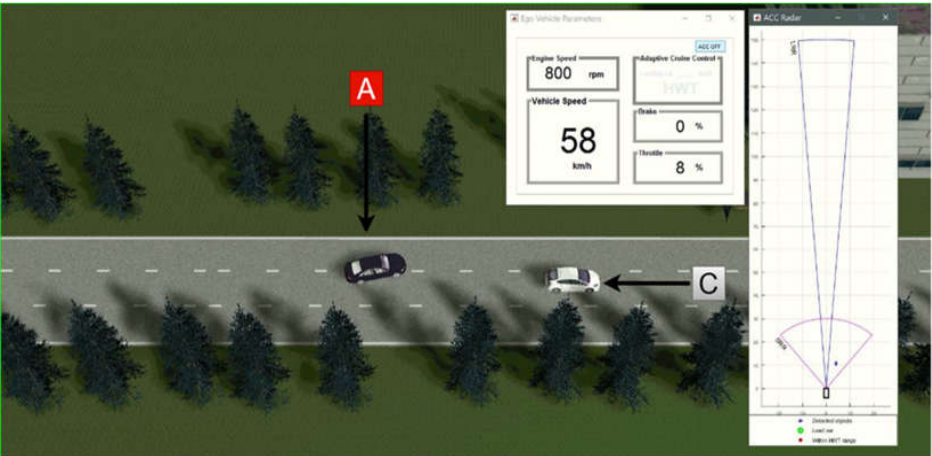
Figure 11. Vehicle A with TIS sensors and ACC controller.